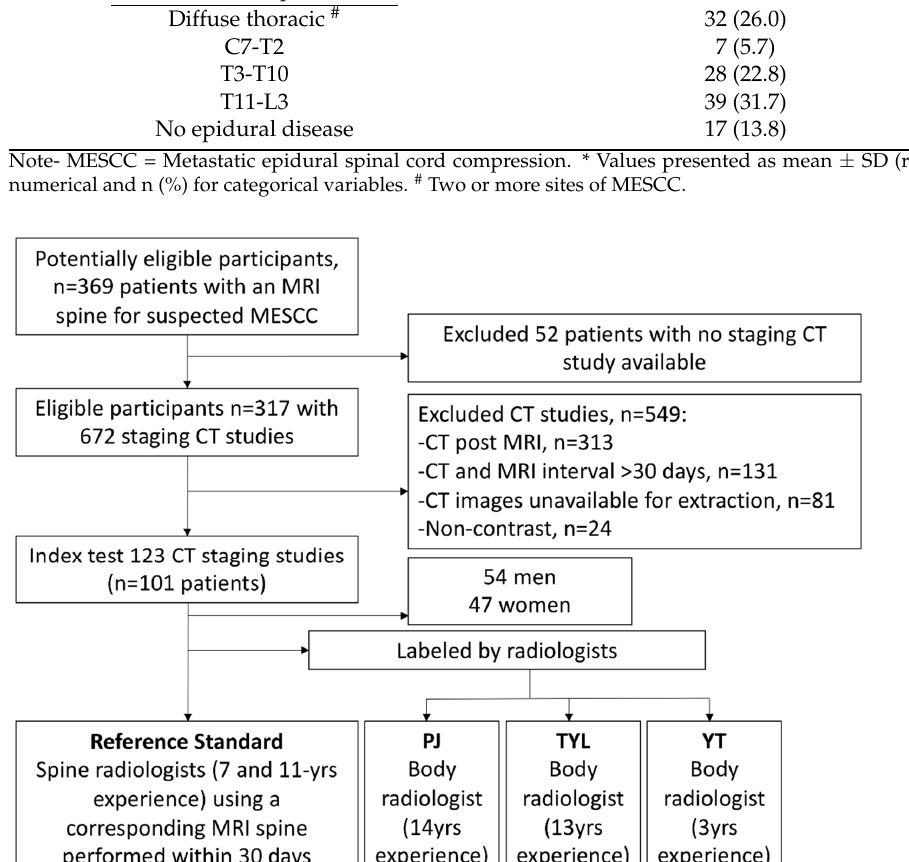
Table 4. Reference standard gradings for metastatic epidural spinal cord compression . Bilsky MESCC